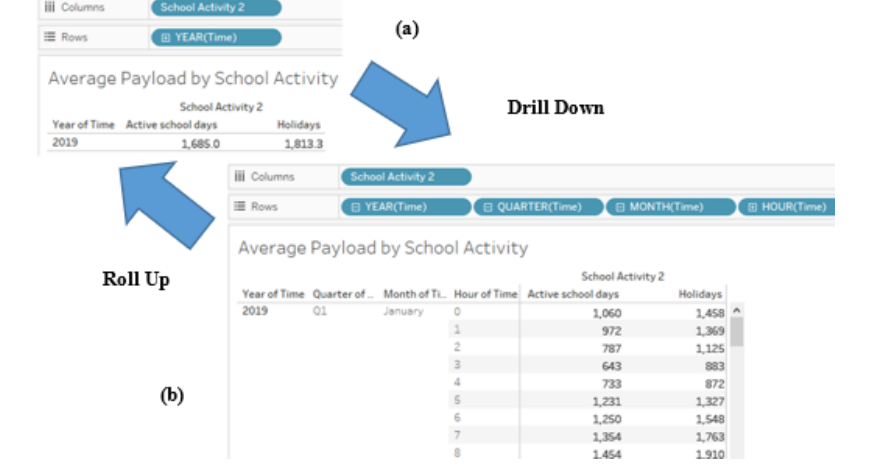
Fig. 6 Drill Down (a to b) – Roll UP (b to a)